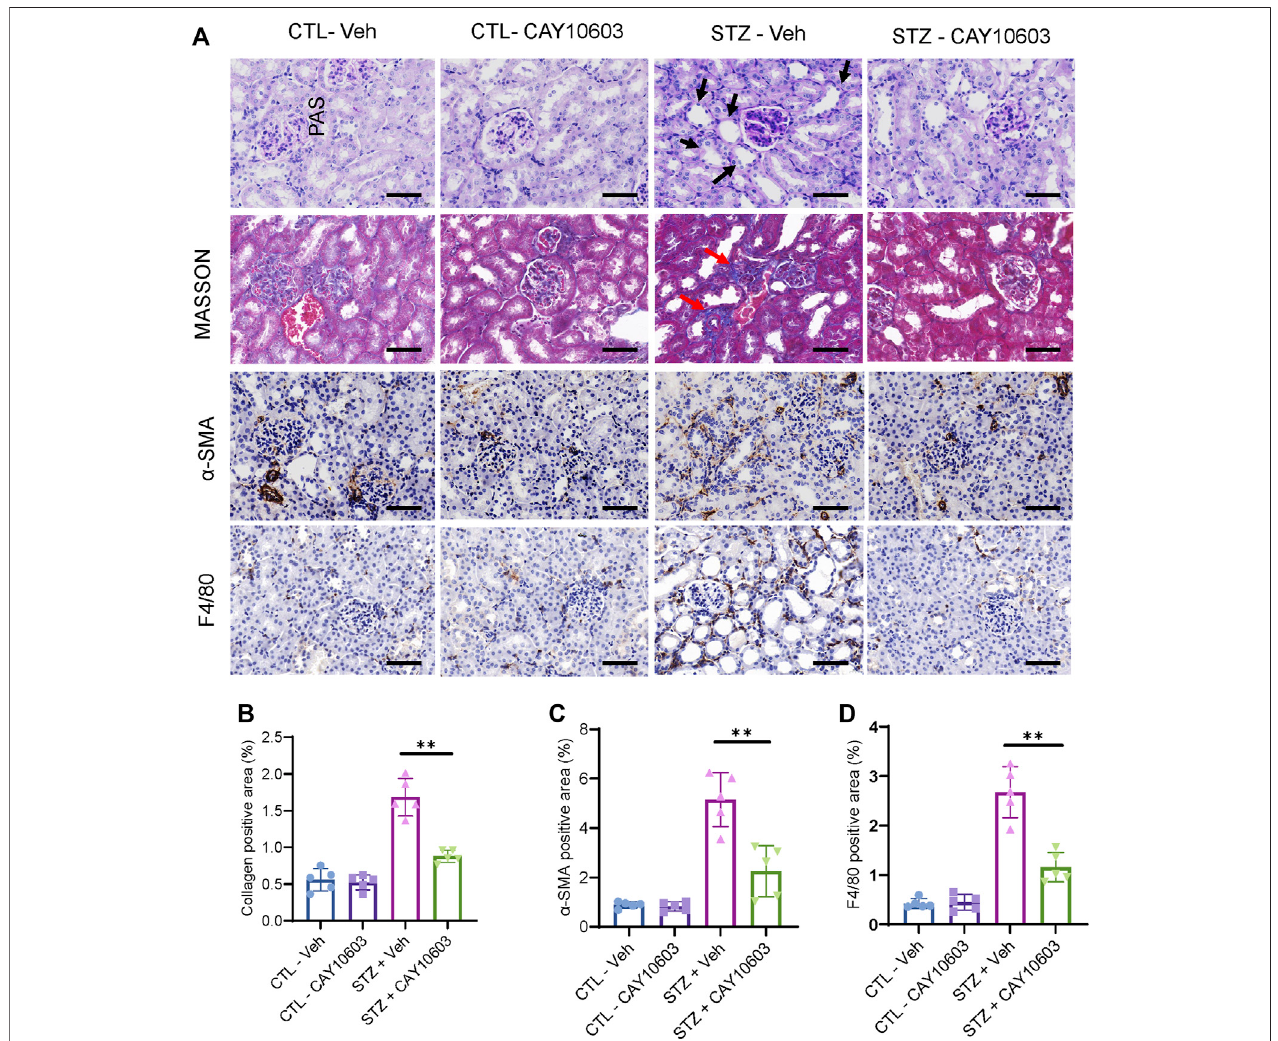
FIGURE4| CAY10603improveskidneyhistologyintheearlystageofdiabeticmice. (A) RepresentativeimagesofPASstaining,Massonstaining,andIHCstaining of α -SMA and F4/80. (B) Quanti fi cation of the positive area for Masson staining. (C) Quanti fi cation of the positive area for α -SMA IHC staining. (D) Quanti fi cation of the positive area for F4/80 IHC staining. Scale bar, 100 µm. Two-way ANOVA. CTL, control; Veh, vehicle.